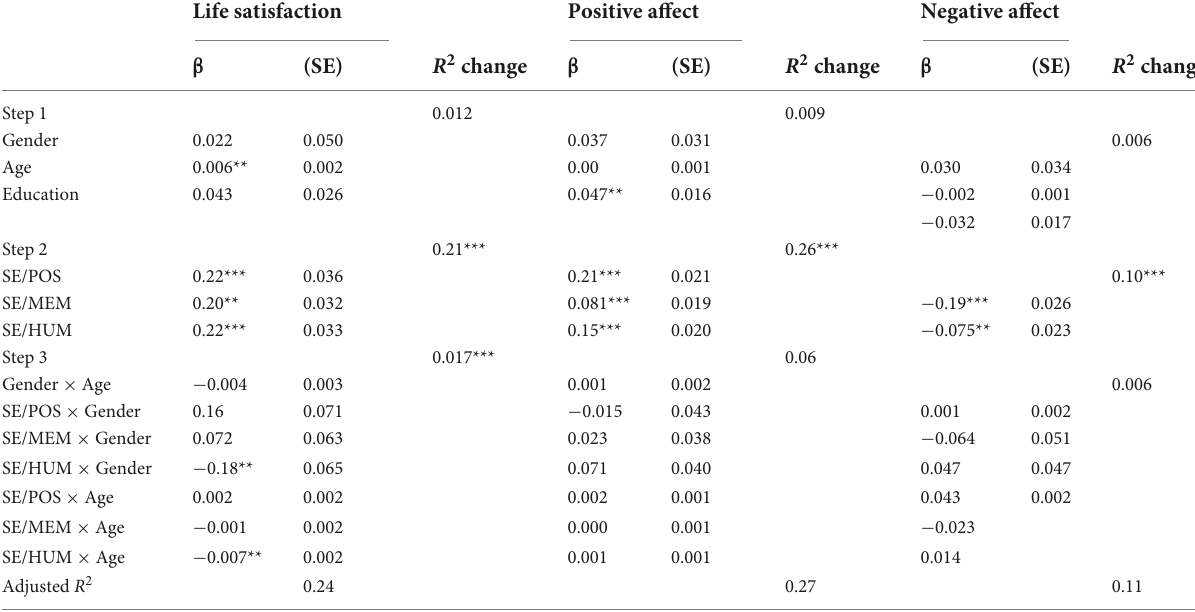
TABLE 5 Results of hierarchical regressions analyses (HRA) of socio-demographic variables and of self-efficacy in managing positive emotions on indicators of wellbeing. Life